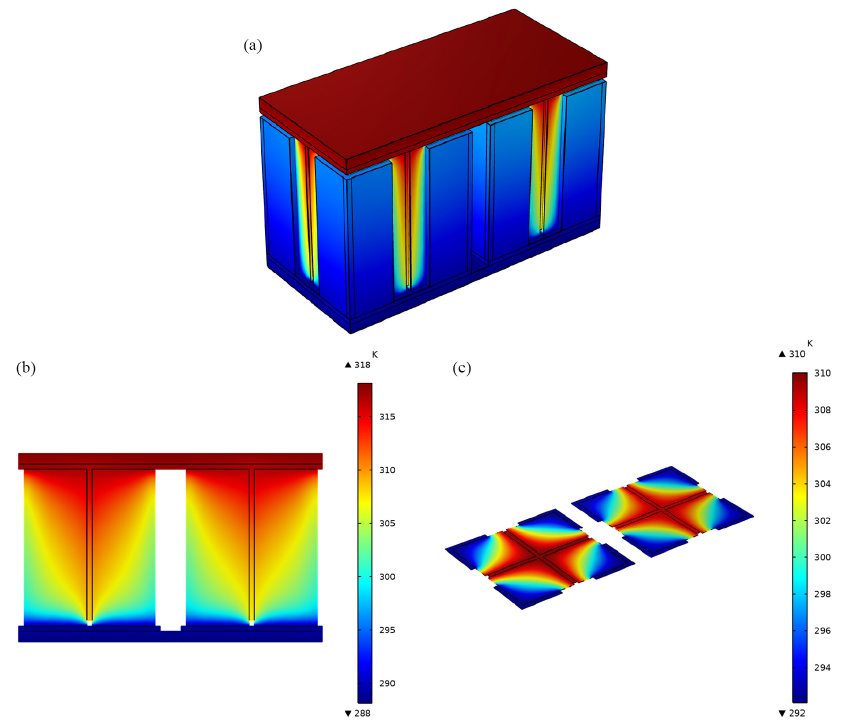
Figure 4. Temperature distribution characteristics: ( a ) three-dimensional temperature distribution, ( b ) vertical profile’s temperature distribution, ( c ) horizontal profile’s temperature